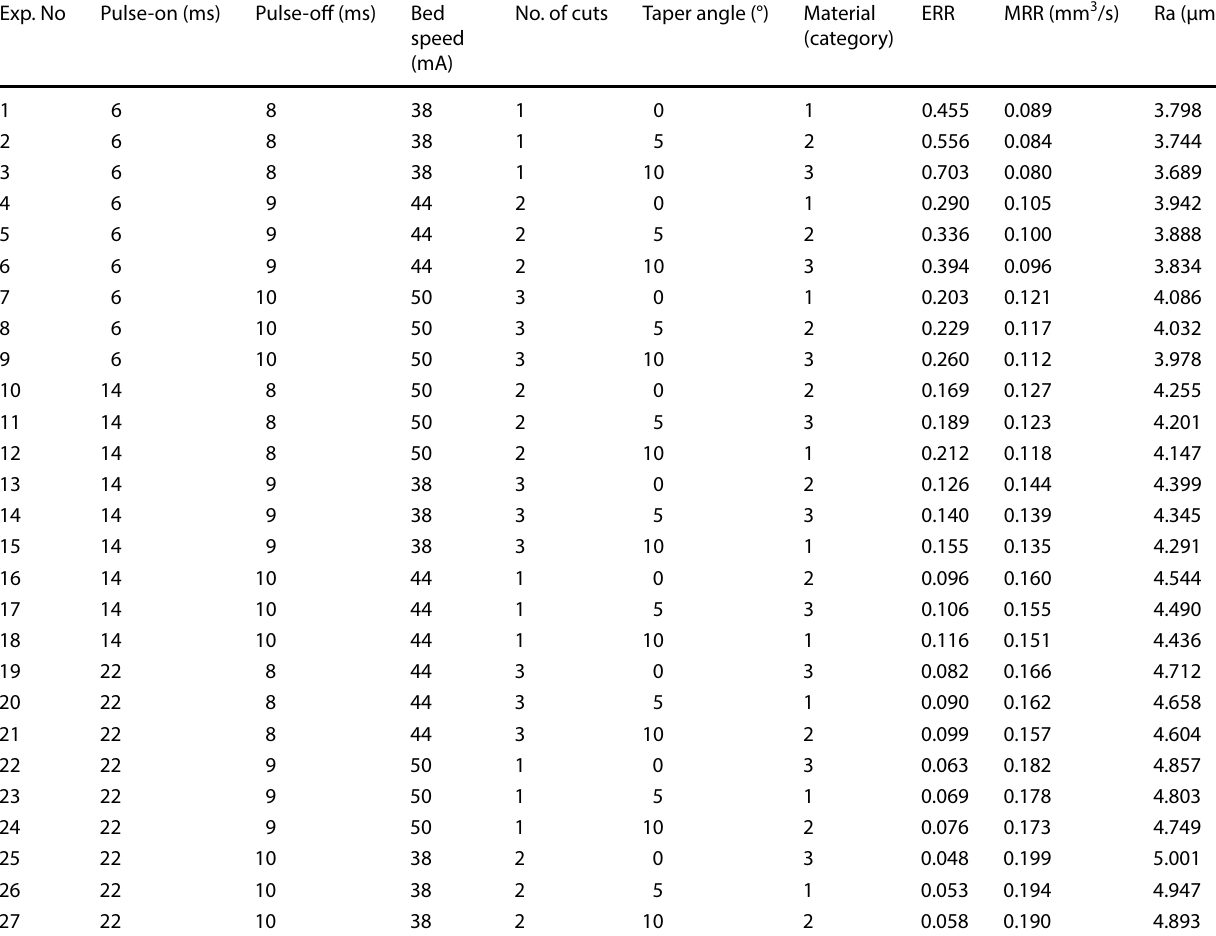
Table 8 Experiments using L27 orthogonal array, and summary of the results Exp.